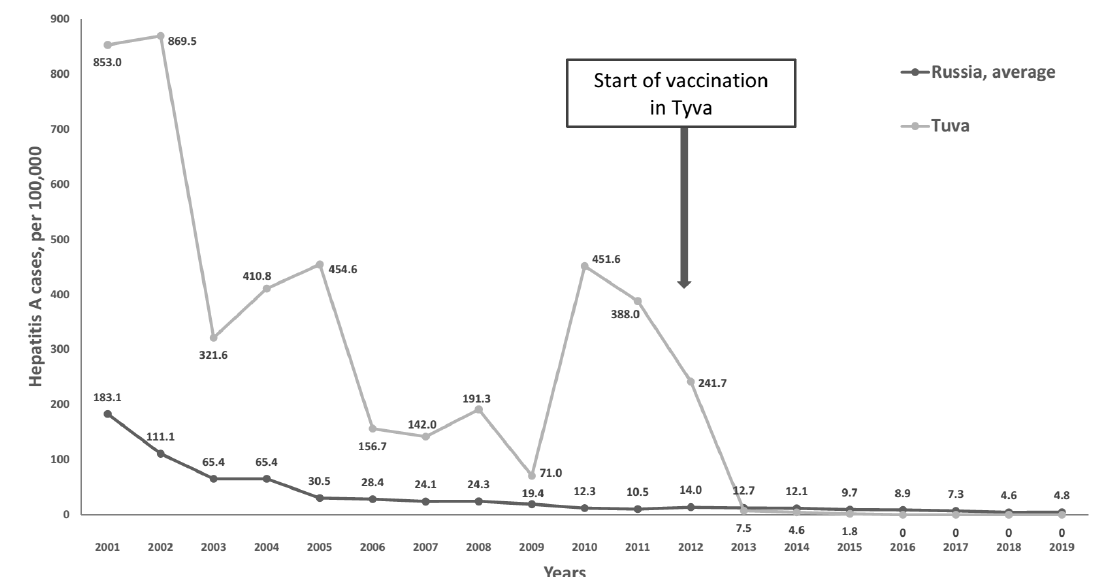
Figure 1. Hepatitis A annual incidence rates in children aged under 18 years in Tuva compared to the average in Russia, 2001–2019. average in Russia,